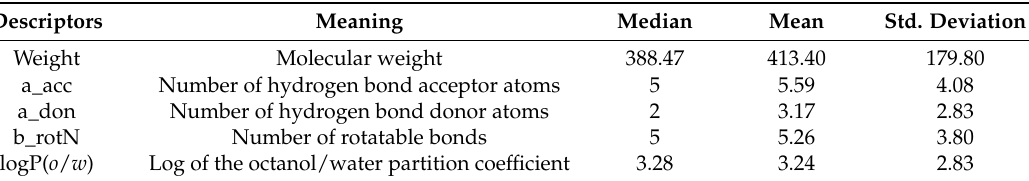
Table 2. Drug-like property descriptors of compounds in WDD.